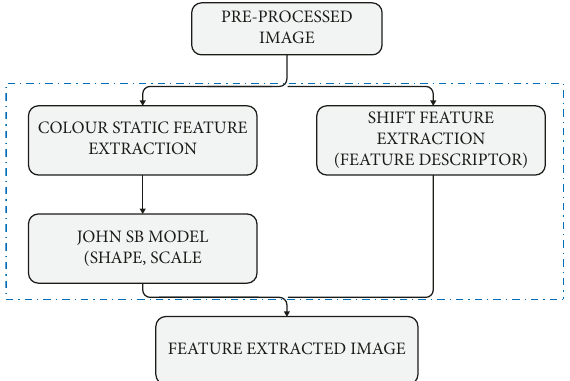
Figure 3: Proposed feature extraction